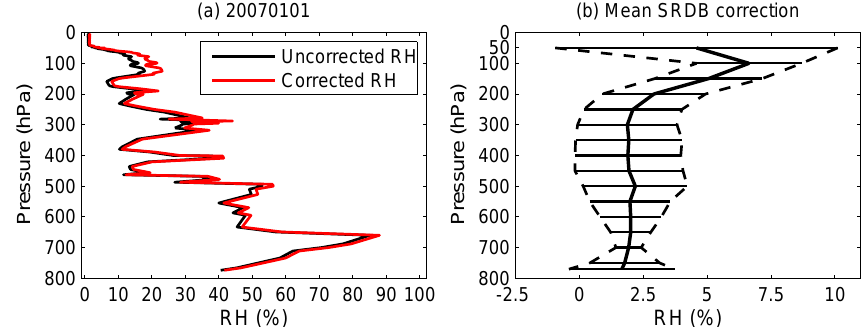
Figure 5. Estimated solar radiation dry bias in radiosonde relative humidity. (a) Typical correction in RH due to SRDB; and (b) mean relative humidity SRDB correction (solid line) and corresponding standard deviation (error